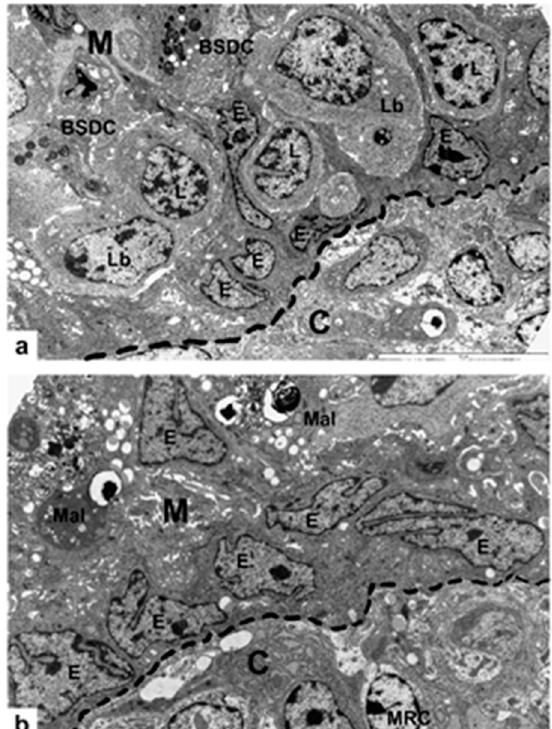
Figure Figure 5. Transmission electron micrographs taken from the V-NC group of chickens. ( a ) This por- tion of CMEA retained the BSDC precursors. C: cortex; M: medulla; E: epithelial cell of CMEA; Lb, L: lymphoblast and lymphoid-like cells; dashed line: cortico-medullary bursal lamina. ( b ) A col- lapsed portion of CMAE, where BSDC precursors are absent and the arch-forming epithelial cells transformed to cuboidal-shaped cells. M: medulla; C: cortex; E: epithelial cells of collapsed CMEA; Mal: macrophage-like cell; MRC: mesenchymal reticular cell; dashed line: cortico-medullary basal lamina .